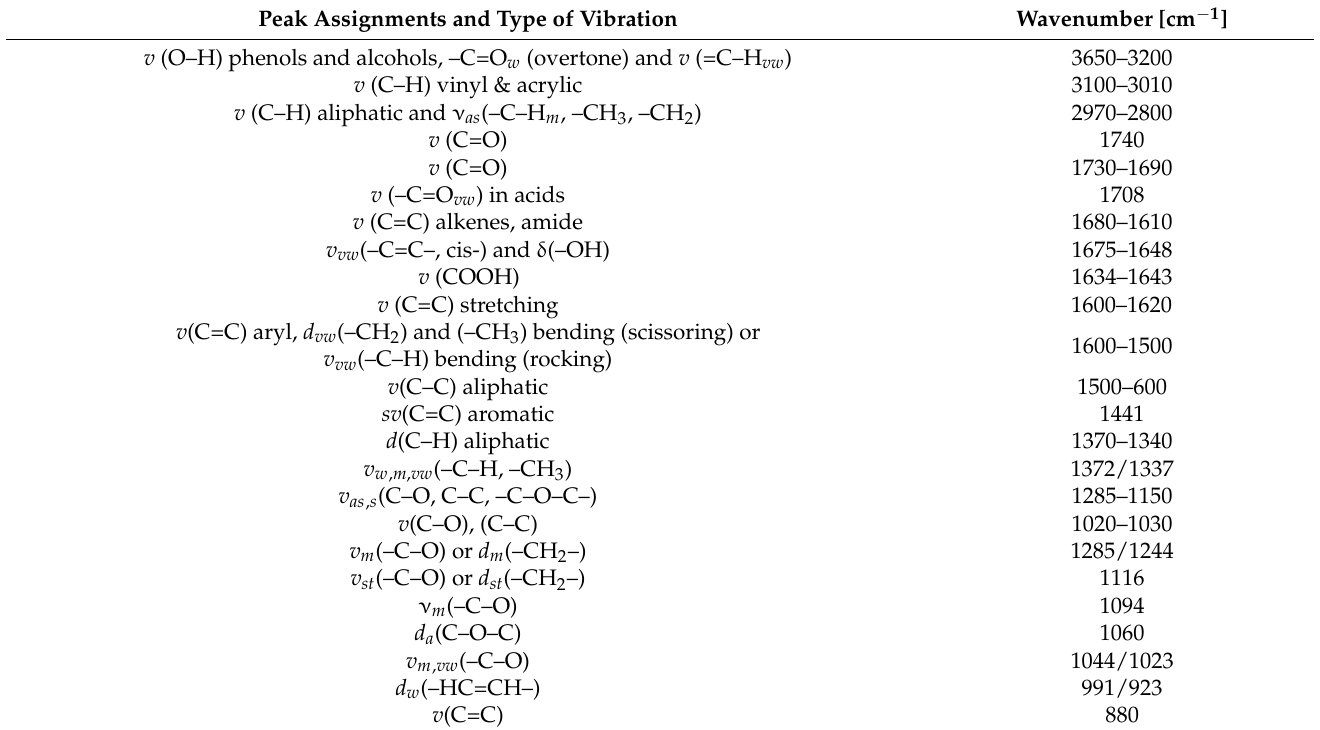
Table 1. Characteristic functional groups registered by FTIR analysis of fillers [84]. Peak Assignments and Type of